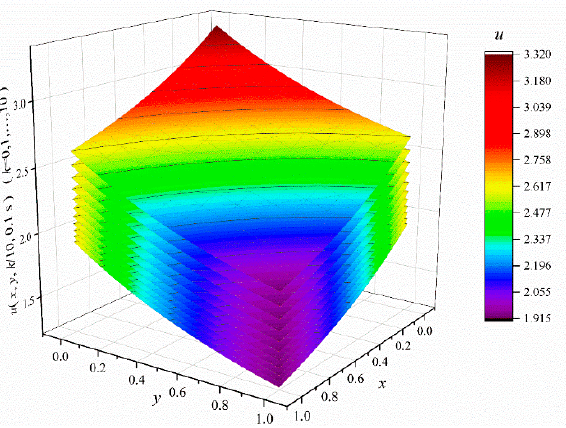
t is different. 0